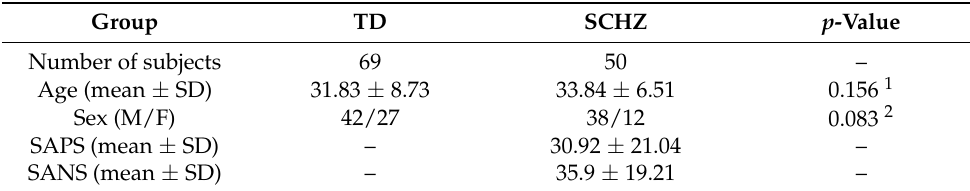
Table 1. Subjects’ characteristics and symptom